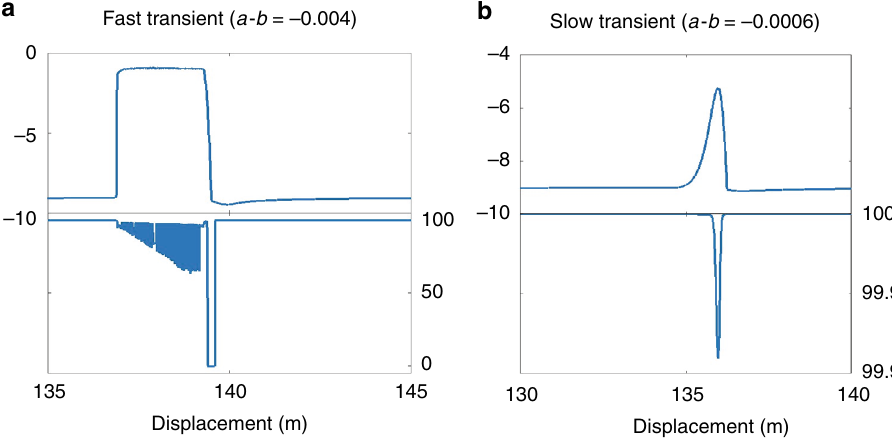
Fig. 6 Work ef fi ciency. Slip velocity and work ef fi ciency for both simulated a fast and b slow transient events